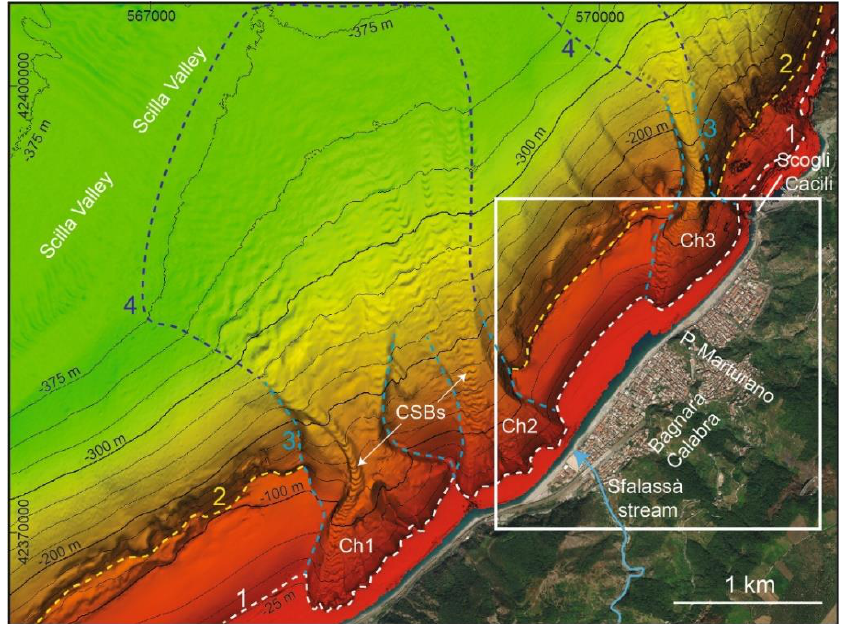
Figure 3. Shaded relief map and isobaths of the continental margin facing Bagnara village, where a narrow continental shelf, deeply carved by three submarine channels (Ch1-3) is present. 1: edge of the near-shore depositional terrace, 2: continental shelf edge, 3: channel sidewall, 4: depositional fan shaped feature. CSBs: crescent-shaped bedforms. Source: multibeam bathymetry data from MaGIC project integrated with Google Earth images.